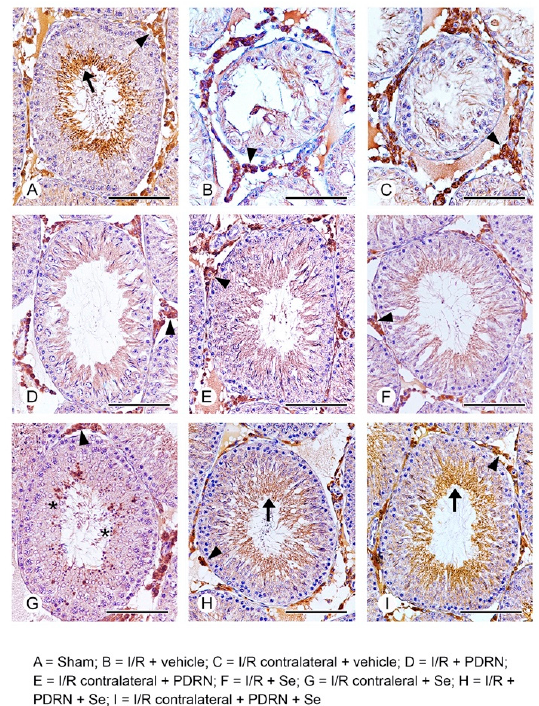
Figure 4. Immunohistochemical expression of HIF-1 α in the testes. ( A ) In sham groups, HIF-1 α positive elongated spermatids and spermatozoa (arrow) and Leydig cells (arrowhead) are present. ( B , C ) In both operated and CL testes of I/R + vehicle rats, no HIF-1 α positive cells are evident in the highly damaged tubular wall; interstitial Leydig cells (arrowhead) show a higher expression versus sham rats. ( D ) In the operated testes of I/R + PDRN-treated rats, a moderate positivity for HIF-1 α of the tails of spermatozoa (arrow) and Leydig cells (arrowhead) is evident. ( E ) In CL testes of I/R + PDRN-treated rats, isolated HIF-1 α positive spermatocytes and spermatids (asterisk) are present in the seminiferous epithelium, in addition to Leydig cells (arrowhead). ( F , G ) In both operated and CL testes of I/R + Se-treated rats, no HIF-1 α positive cells are present in the otherwise improved structure of seminiferous tubules; the expression of Leydig cells (arrowhead) is reduced when compared with I/R rats. ( H , I ) In the seminiferous tubules of both operated and CL testes of I/R + PDRN + Se-treated rats, an evident positivity for HIF-1 α of the tails of spermatozoa (arrow) and Leydig cells (arrowhead) similar to sham is present. (Scale bar: ( A , D–I ) = 100 µ m; ( B , C ) = 50 µ